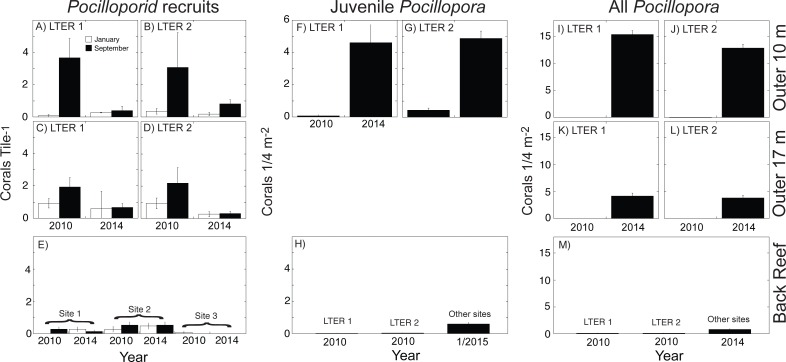
Abundance of three life stages of Pocillopora spp. on the north shore of Moorea in 2010, 2014, and January 2015 for pocilloporid recruits (A–E), juvenile Pocillopora spp. colonies (F–H), and all Pocillopora spp. colonies (I–M).Values shown are mean ± SE for the outer reef at 10-m depth (upper row), outer reef 17-m depth (middle row), and back reef (lower row); data are not available for juvenile corals at 17-m depth. Recruits were censused in January and September of each year, and all other surveys were conducted in April and May. (A–D) recruits at LTER 1 and 2, (E) recruits at three back reef sites in the middle of the north shore, (F, G) juveniles at LTER 1 and 2, (H) juveniles at LTER 1 and 2 in 2010, and at multiple sites in January 2015, (I–L) all Pocillopora spp. colonies at LTER 1 and 2, and (M) all Pocillopora spp. colonies at LTER 1 and 2 in 2010, and at multiple sites in January 2015.